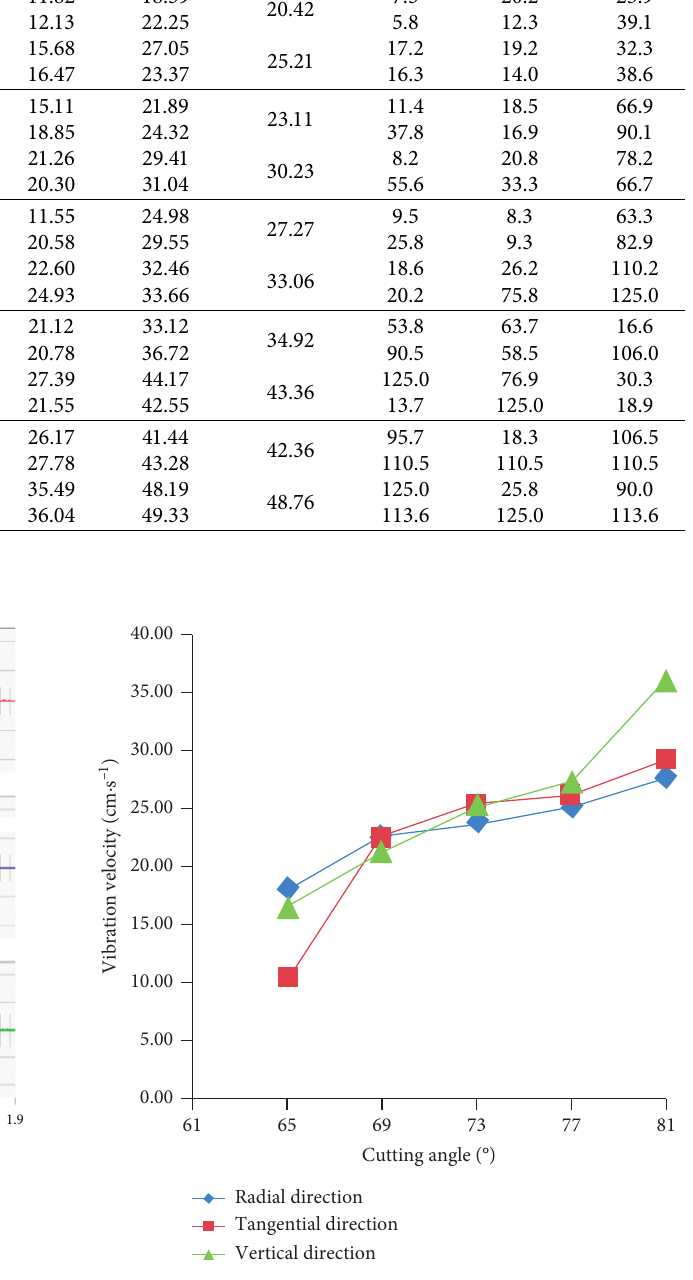
Figure 23: The curve of the maximum peak velocity with the change of cutting